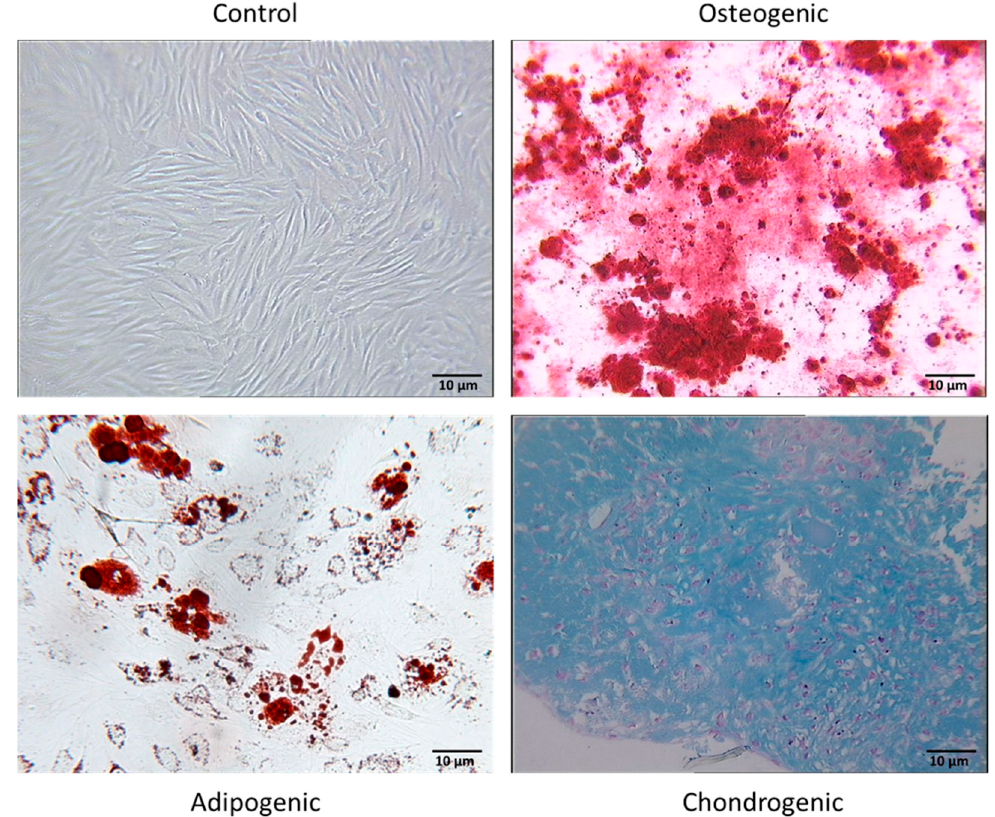
Figure 2. The multilineage potential of FSK-MSCs. The in vitro differentiation profile of human FSK- MSCs was assessed by using special induction medium and staining techniques (magnification 100 × ). A representative example of osteogenesis from FSK-MSCs was evaluated after 21 days of induction by Alizarin red staining to color calcium deposits (mineralization). A representative example of adipogenesis from FSK-MSCs was evaluated after 7 days of induction by Oil Red O staining to color lipid vacuole formation. A representative example of chondrogenesis from FSK-MSCs was evaluated after 21 days of induction by Alcian blue staining to color extracellular matrix (pro- teoglycans).